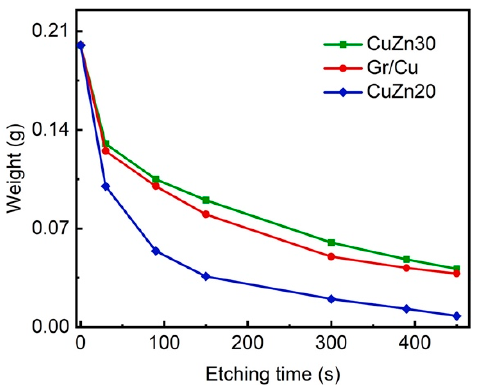
Figure 5. A comparative anticorrosion performance test between Gr/Cu microparticles and Cu-Zn alloy powders.